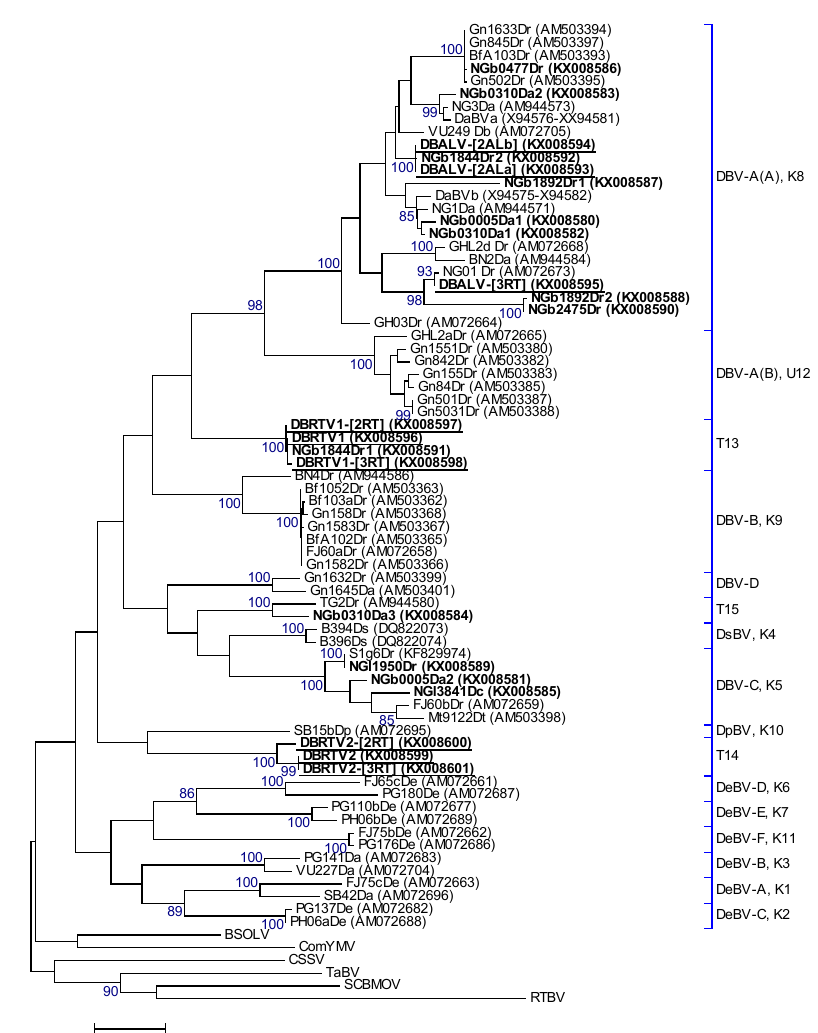
Figure 2. Bootstrap consensus phylogenetic tree using Maximum Likelihood method built from badnavirus 528 bp long partial RT-RNaseH nucleotide sequences of 22 yam badnavirus sequences determined in this study representing two already described and three newly proposed distinct monophyletic species groups (T13, T14, T15). Included in the analysis are partial RT-RNaseH sequences from GenBank of previously analysed yam samples by Seal et al. [3] and Eni et al. [8]. Equivalent sequences from CSSV (AJ781003), BSOLV (AJ002234), ComYMV (NC001343), SCBMOV (M89923), TaBV (AF357836) and outgroup RTBV (X57924) were added, as well as representative sequences of all monophyletic groups described by Bousalem et al. [9], where DBV-A = Dioscorea bacilliform virus A (A and B subgroups); DBV-B = Dioscorea bacilliform virus B; DBV-C = Dioscorea bacilliform virus C; DBV-D = Dioscorea bacilliform virus D; DeBV-A = Dioscorea esculenta bacilliform virus A; DeBV-B = Dioscorea esculenta bacilliform virus B; DeBV-C = Dioscorea esculenta bacilliform virus C; DeBV-D = Dioscorea esculenta bacilliform virus D; DeBV-E = Dioscorea esculenta bacilliform virus E; DeBV-F = Dioscorea esculenta bacilliform virus F; and DpBV = Dioscorea pentaphylla bacilliform virus. One monophyletic group denoted by Umber et al. [30] and 11 corresponding Kenyon et al. [2] groupings to these monophyletic groups are also given and denoted by U12 and K1–K11 respectively. Sequence names: bold = partial RT-RNaseH sequences from RCA clones, bold and underlined represent partial RT-RNaseH sequences and their GenBank accessions of the characterised full-length genomes obtained in this study. The bootstrap analysis of the sequences was 1000 replicates and the cut-off value was